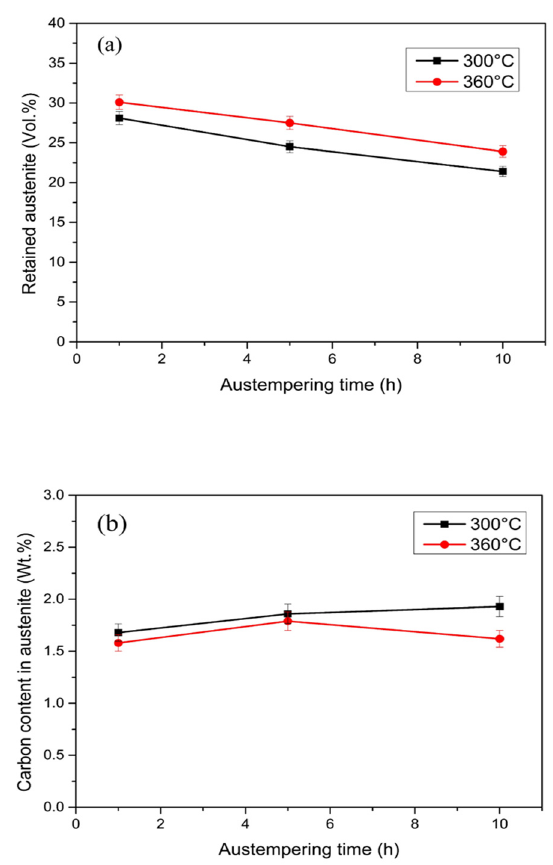
Figure 4. XRD patterns of the ADIs in the study.